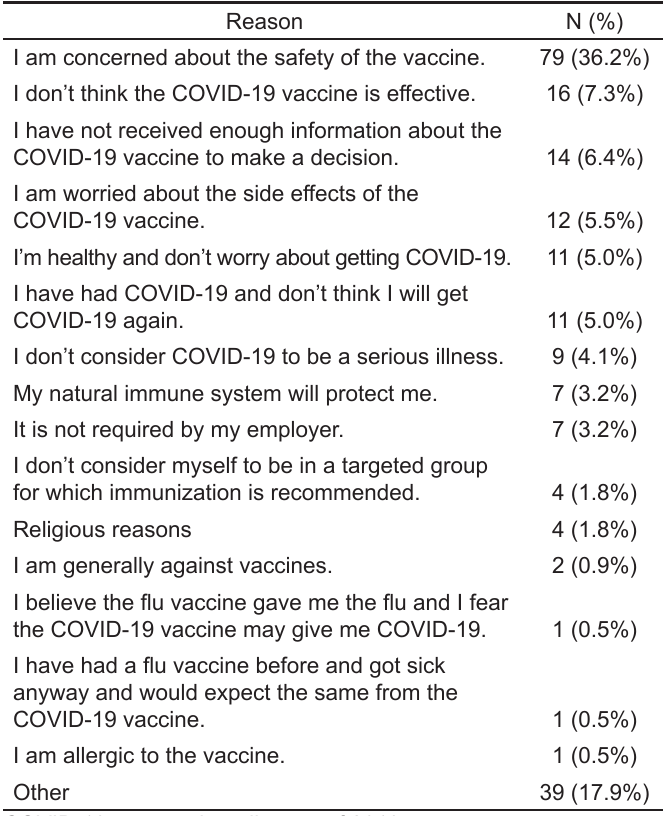
Table 3. Primary reason why respondents did not receive COVID-19 vaccination